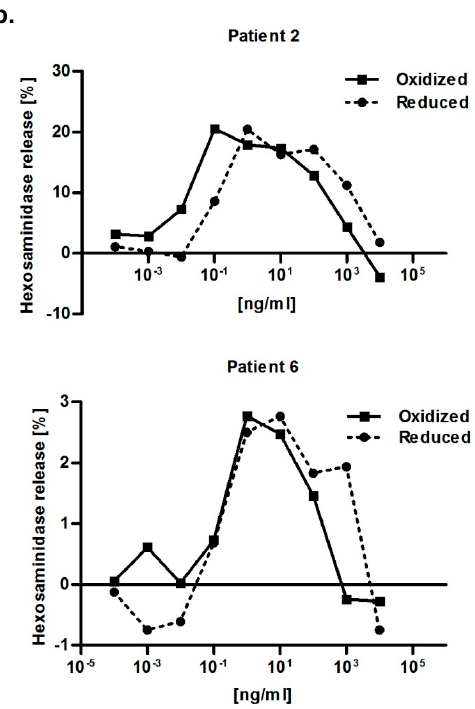
Figure 4. Immunological reactivity of Bet v 2. ( a ) ELISA assay of birch pollen allergic patients reactive to Bet v 2. The dashed line represents the limit of detection calculated from blank control with three times standard deviation; ( b ) Mediator release assay of the two birch pollen allergic patients with highest IgE binding as observed in ( a ); Patient two and six correspond to the numbers shown in the ELISA in panel ( a ). A non-allergic individual showed no release of hexosaminidase (data not shown). The shown hexosaminidase release was background corrected.